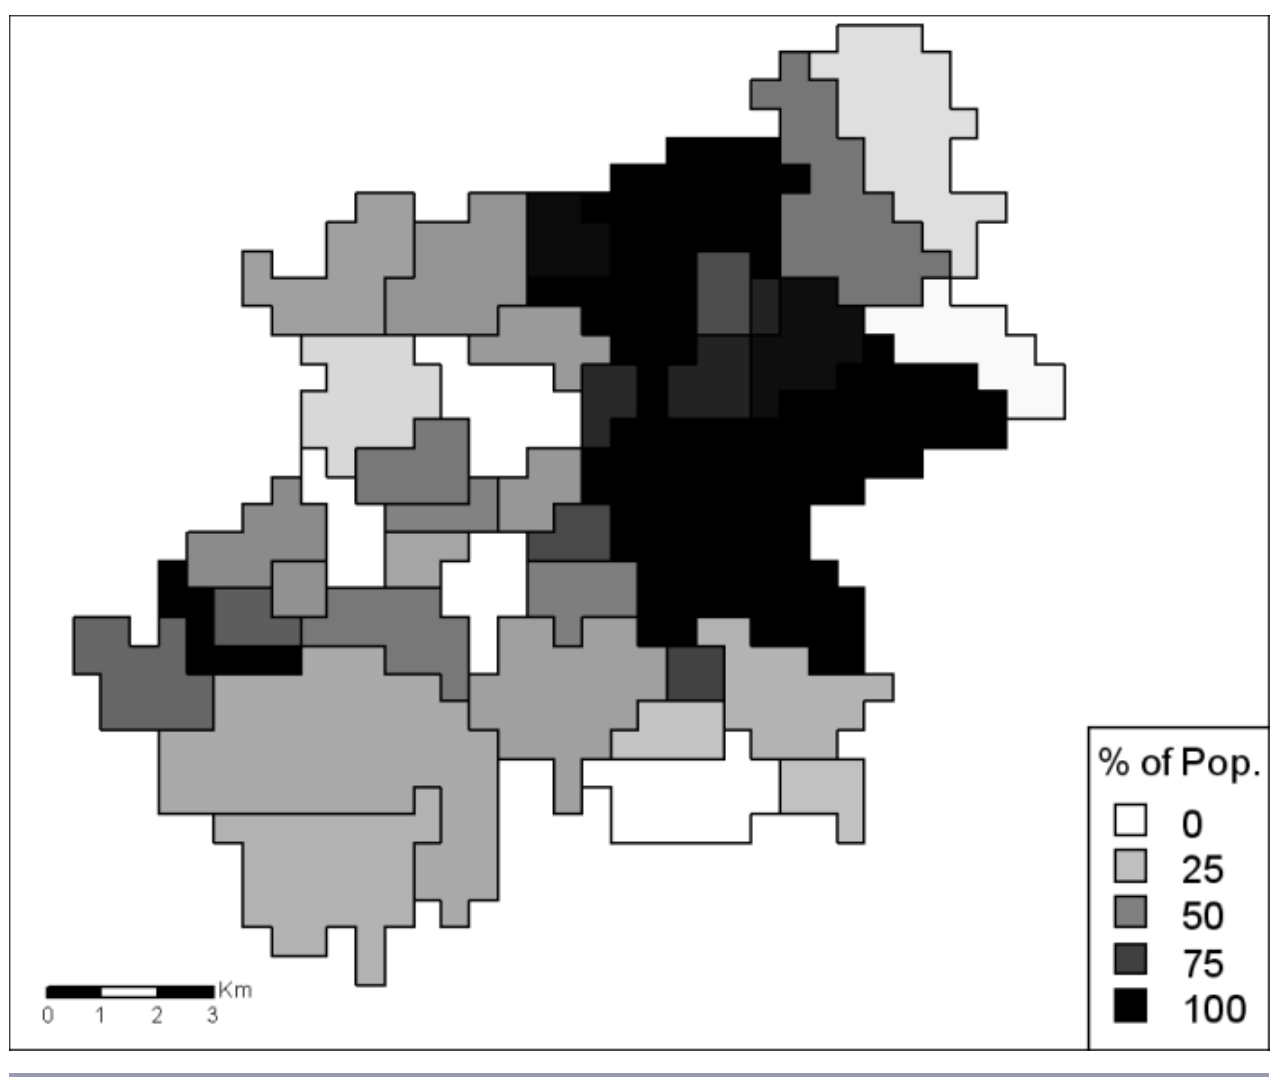
Fig. 3. The percentage of human population in neighborhoods with below-average bird diversity at the municipal district